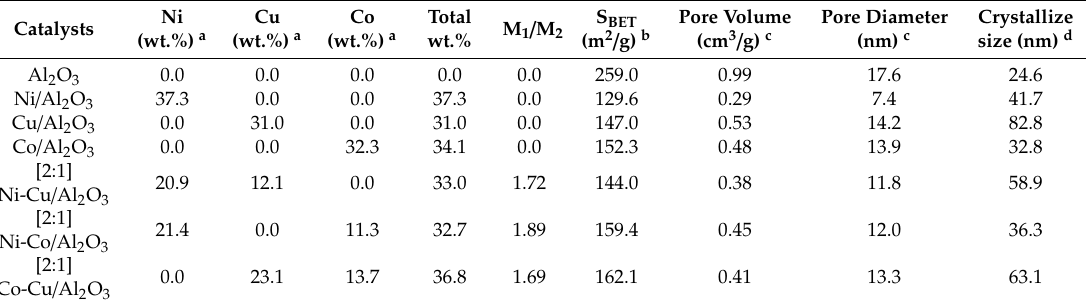
Table 1. Elemental and textural characterization of the reduced